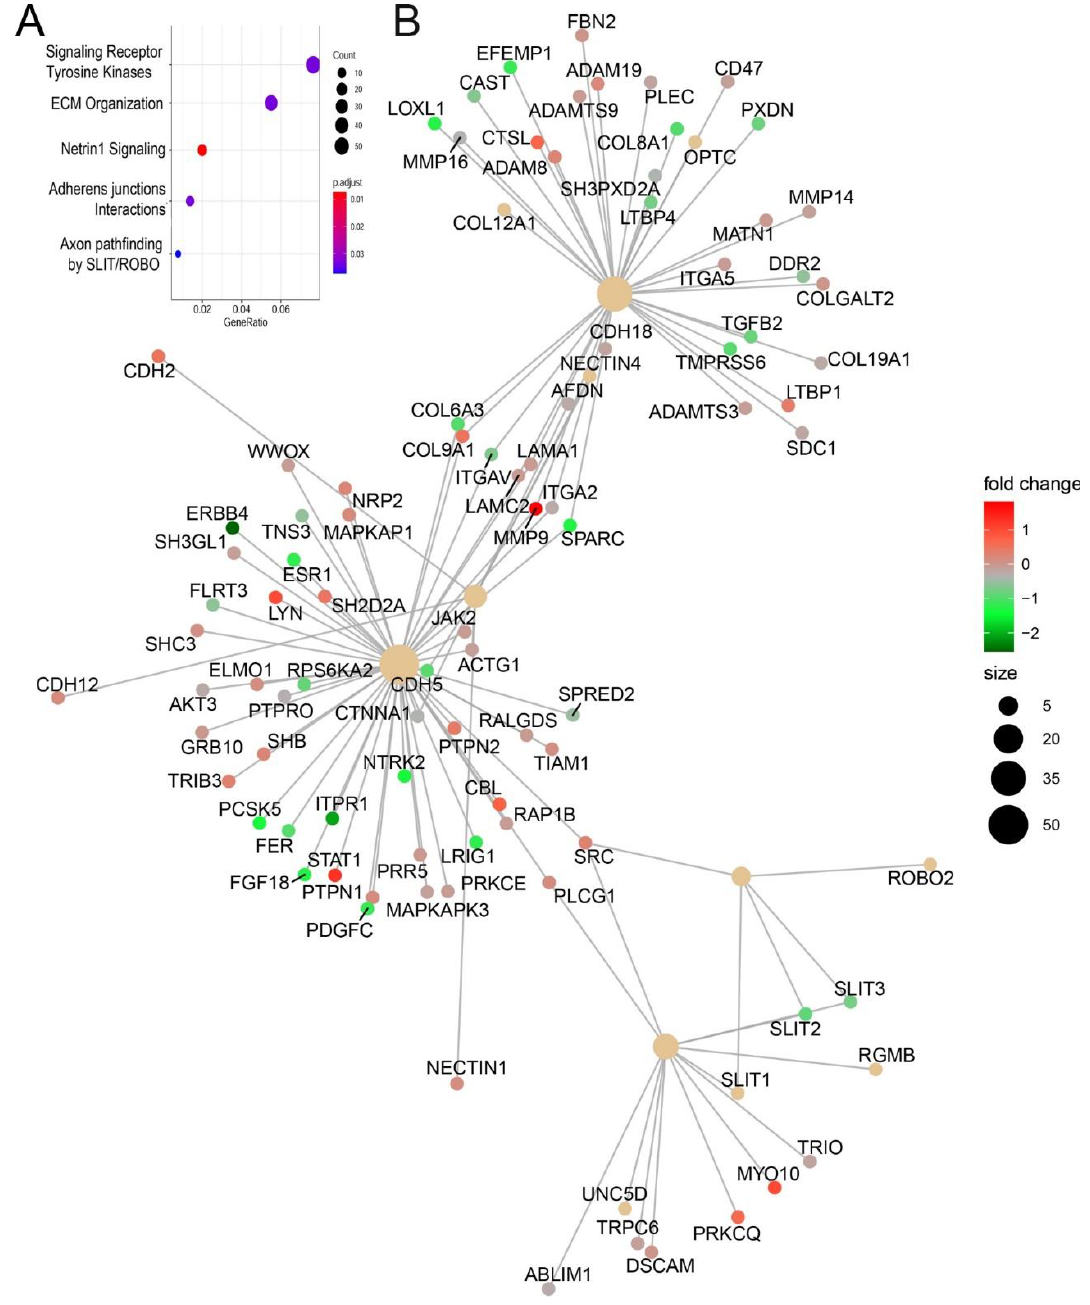
Figure 10. Pathway analysis of genic regions associated with RSV induced open chromatin domains. ( A ) Shown are genome ontologies ranked by the number of genes in a pathway (gene ratio) and by enrichment relative to genome ( p value). ( B ) Integrated network analysis of genes shows 3 major functional pathways are a ff ected by RSV induced changes in chromatin accessibility. Node size and fold change in nucleosome free domain are indicated in the legend.